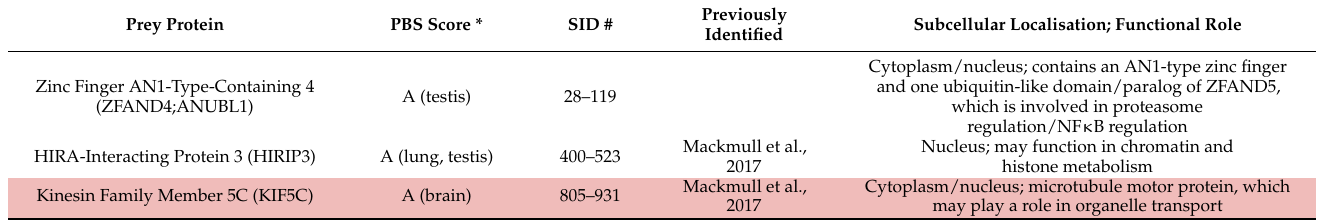
Table 1. IPO13 interacting proteins identified by yeast-2-hybrid screen of a human testis, lung, and brain cDNA libraries using mouse IPO13 as a bait. * Predicted Biological Score (PBS Score) indicates the confidence of interaction (A being highest)—the highest PBS score obtained for each protein is given, and the screens in which the interaction was detected (at any level) are given in parentheses; # Selective interactive domain (SID) is the minimal sequence shared by all fragments of the respective protein that interacts with IPO13. N indicates proteins for which only non-sense transcripts were identified, and, as such, a SID could not be calculated. Pathways analysis was performed using the DAVID Bioinformatics Resources 6.8, using the Functional Annotation Tool for 59 of 62 IPO13 interactors that were annotated as described in Materials and Methods. Proteins annotated to stress response are blocked in red. Proteins annotated to nuclear transport are indicated by NT in the functional role